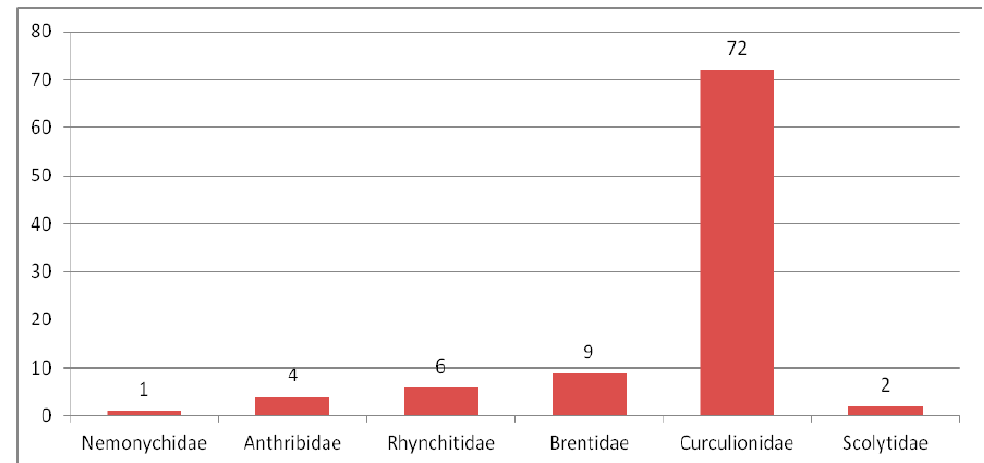
Figure 22. Composition of species of Curculionoidea in the Oligocene.